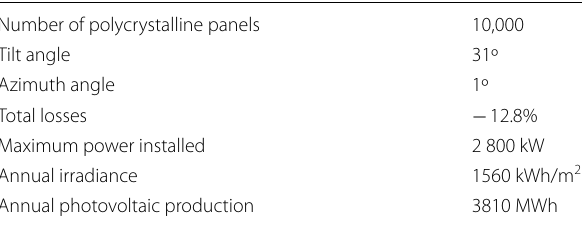
Table 15 Flores system design data with polycrystalline photovoltaic panels Number of polycrystalline panels